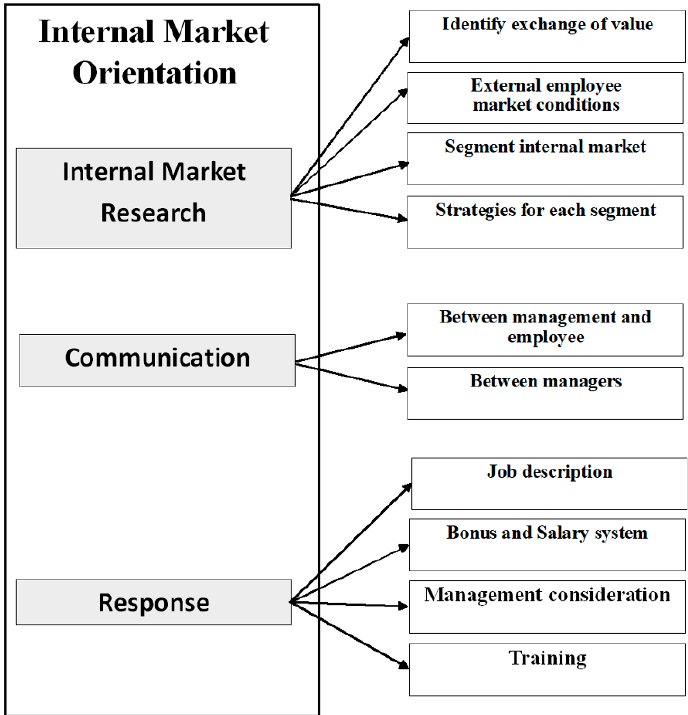
Figure 1. Dimensions of internal market orientation. Source: (Lings 2004). Reproduced with permission from Ian N. Lings, Journal of Business Research; published by Elsevier, 2004.